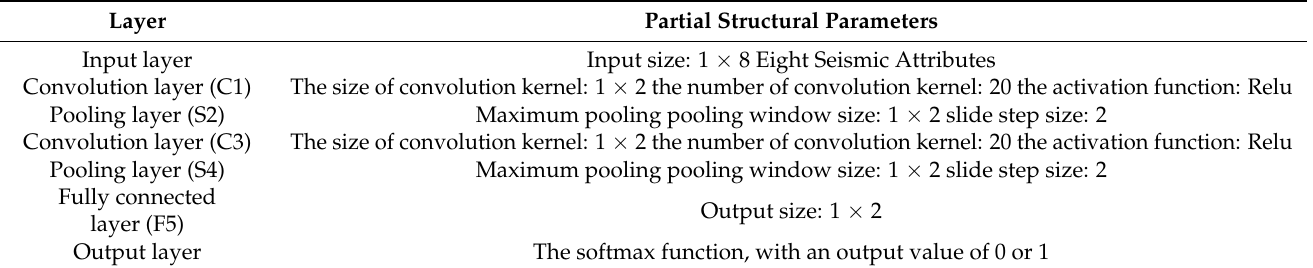
Table 3. Structural parameters of the